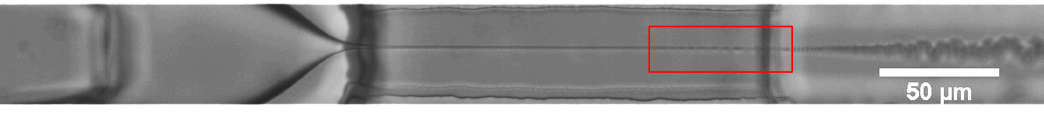
Figure 11. Tip-streaming